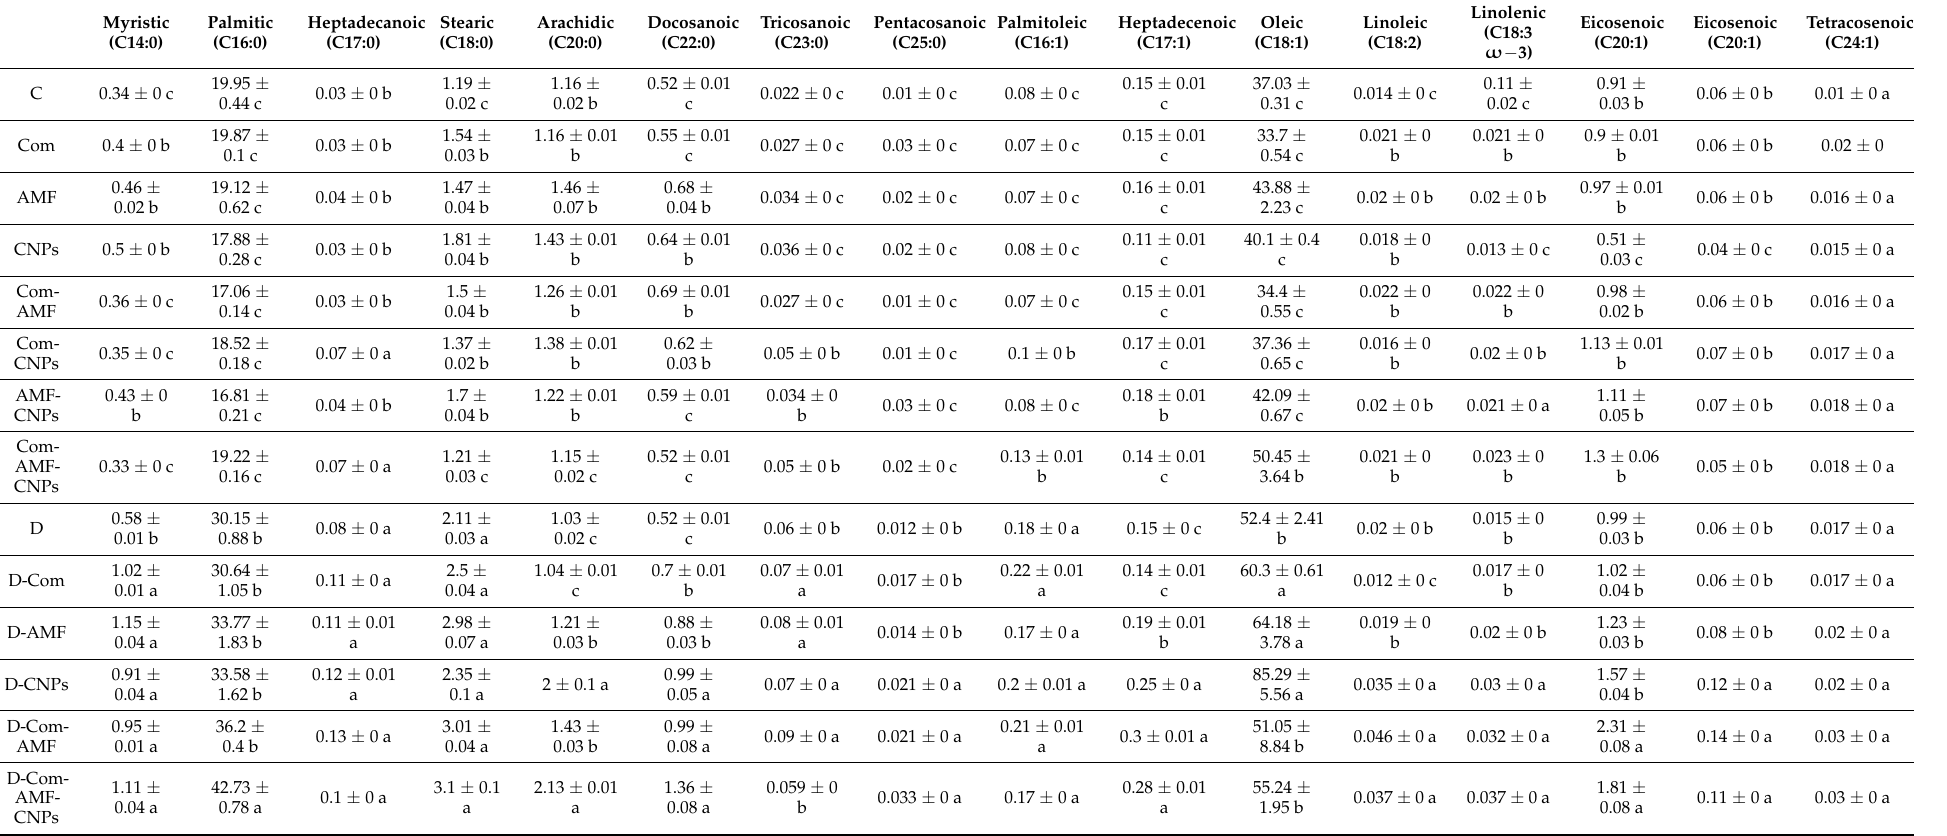
Table 5. Effect of different treatments on fatty acids ( µ g/g FW) of maize under control and drought (D) conditions. Different letters indicate statistically significant difference between means for the different treatments at significance level of at least p ≤